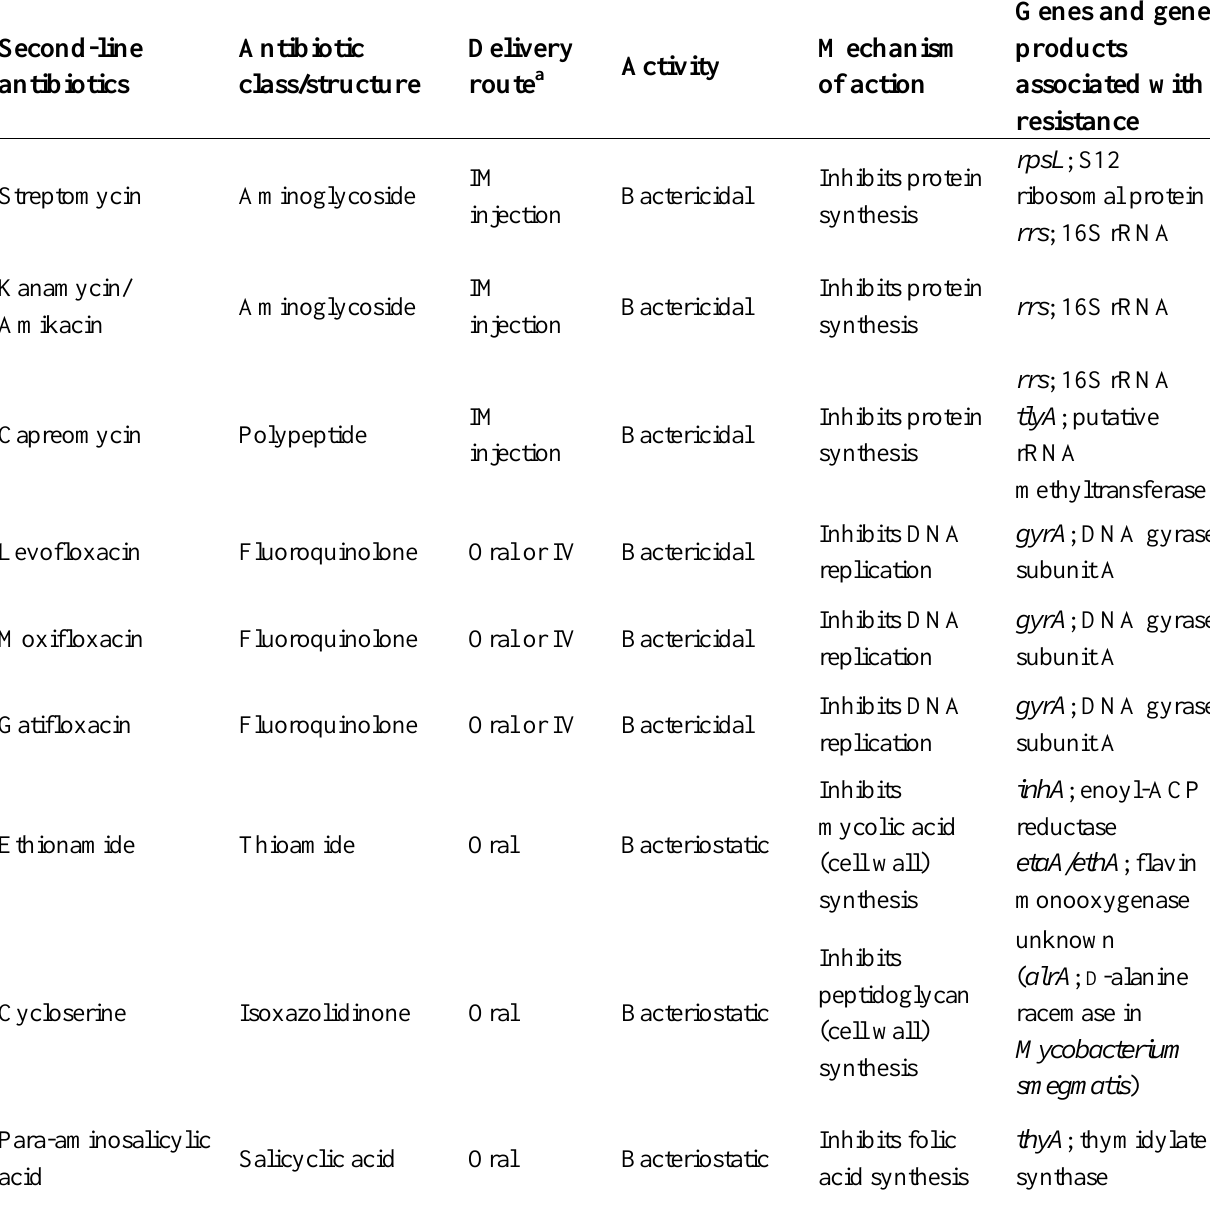
Table 3. Second-line anti-TB drugs